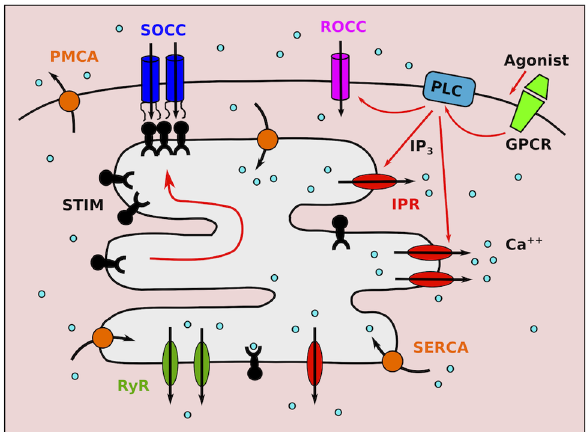
Figure 1. Schematic of Ca 2 z signalling in ASMC. Agonist stimulation of G-protein coupled receptors (GPCR) induces PLC b activation, giving rise to IP 3 production and Ca 2 z entry through receptor-operated Ca 2 z channels (ROCC). IP 3 triggers Ca 2 z release through IPR. Depletion of the SR from Ca 2 z causes STIM protein oligomerisation and migration toward the cell membrane, where they bind and activate store-operated Ca 2 z channels (SOCC). Ca 2 z ATP-